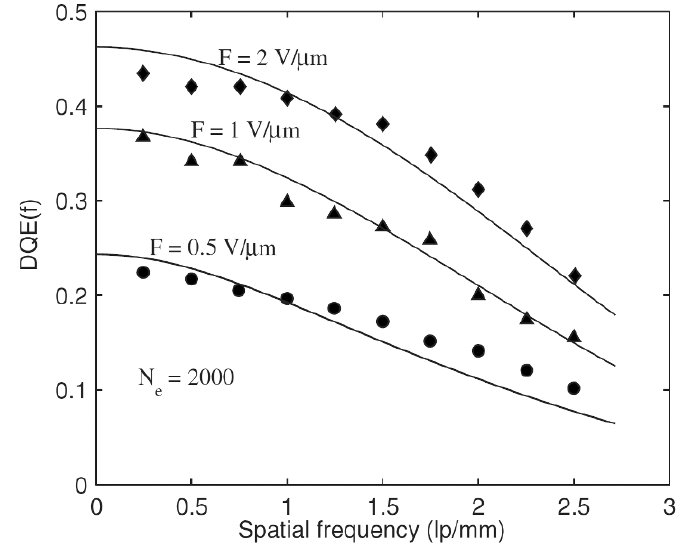
Figure 9. DQE( f ) vs. spatial frequency f for a negatively biased PbO photoconductive x-ray sensor at three different applied fields, F = 0.5 V  m −1 , 1 V  m −1 , and 2 V  m −1 . The symbols are the experimental points reported by Simon and coworkers and the solid line is the calculations based on a cascaded linear system model; further details may be found in